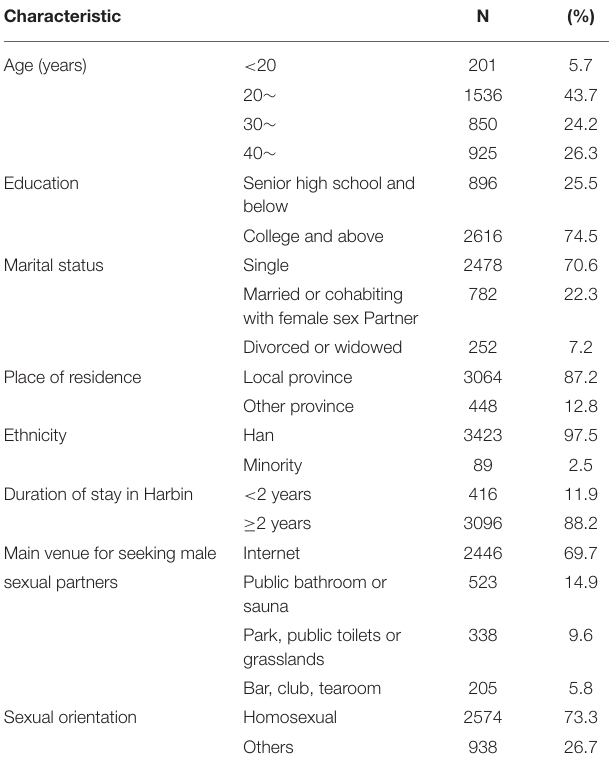
TABLE 1 | Baseline characteristics of the